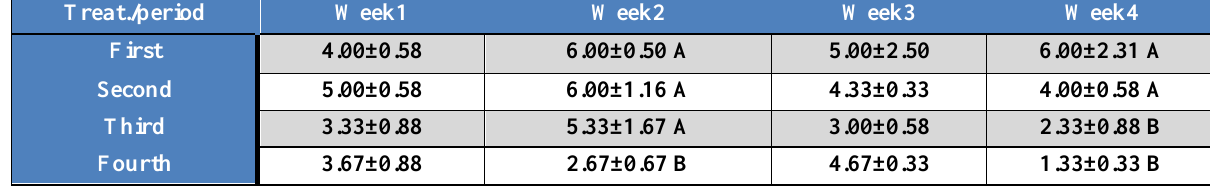
Table, 8: Effect of Vit. C and/or Vit.B on the Eosinophil percentage % of rabbits (Mean ± SE).